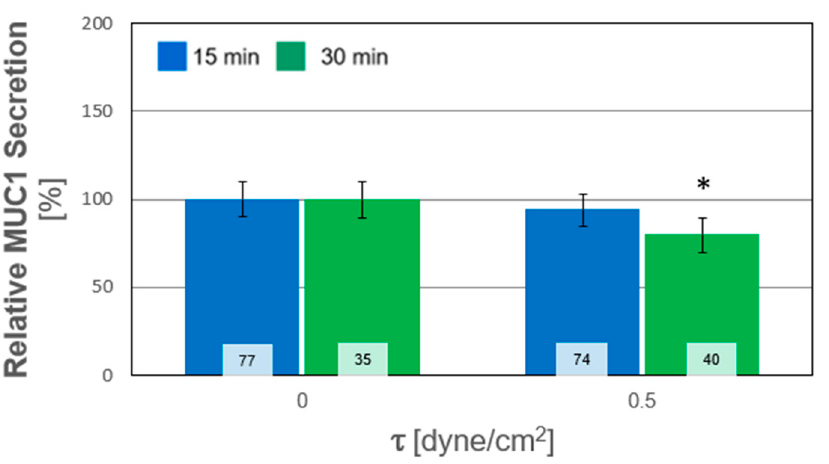
Figure 8. Combined MUC1 secretion measurements in cultured human conjunctival epithelial cells (HCEC) from all tests of exposure to wall shear stresses (WSS) of 0.5 dyne/cm 2 for durations of 15 min and 30 min. The data obtained after exposure to WSS were scaled by the averaged data for the unexposed controls. * stands for p < 0.05, with respect to the static cultures. The values inside the bars denote the number of data points calculated from the sub-regions (n).